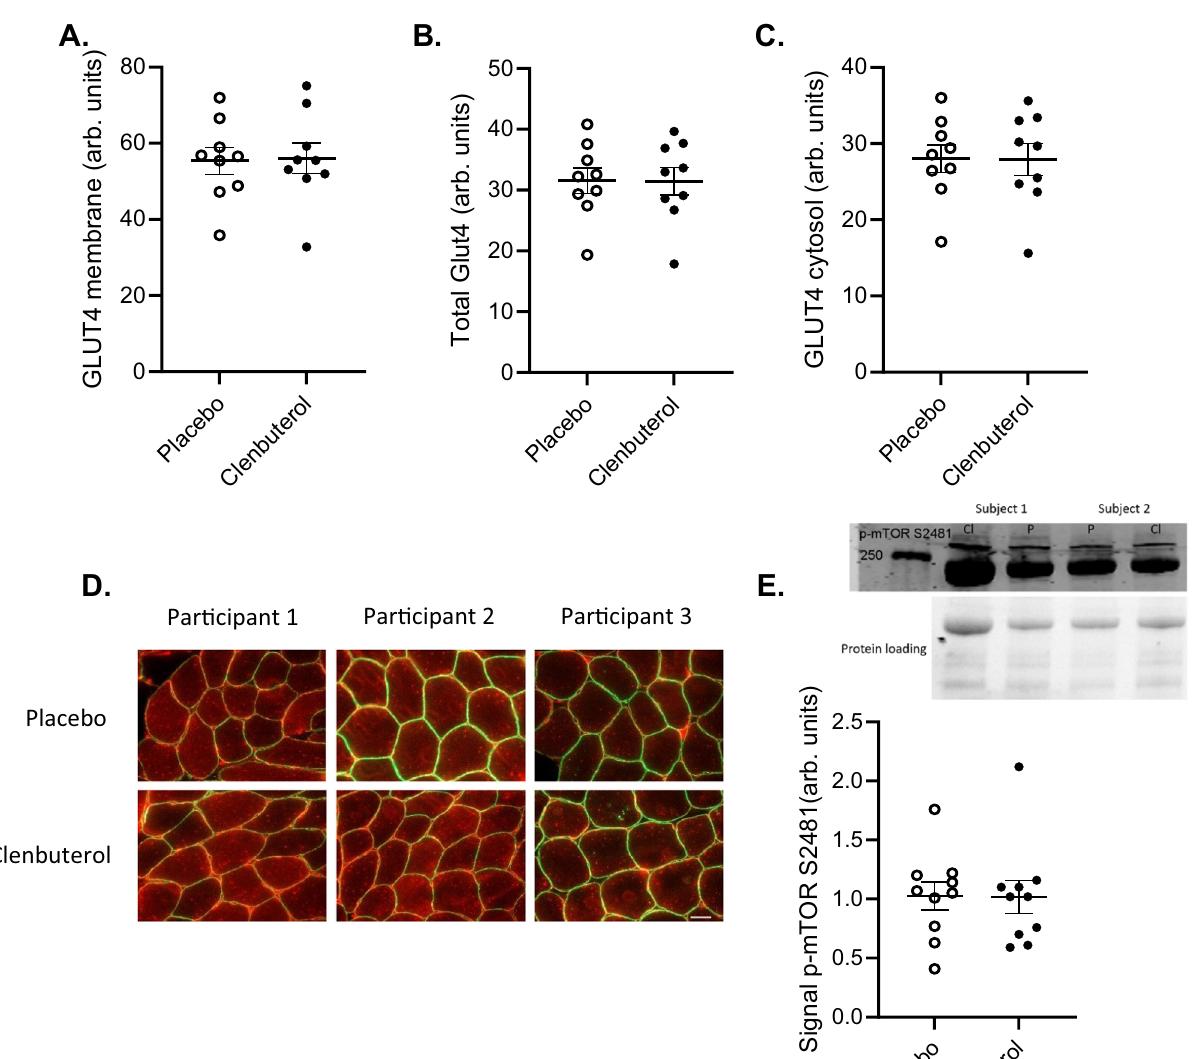
Fig.3|ProlongedclenbuteroltreatmentdoesnotaffectskeletalmuscleGLUT4 translocation or mTORC2 activation. A GLUT4 content at the myocellular cell membrane(arb.units). B TotalGLUT4content(arb.units). C GLUT4contentinthe myocellular cytosol (arb. units) D Representative images of GLUT4 immunohis- tochemistry staining for three participants, scale bar 50 µ m. E Phosphorylation of